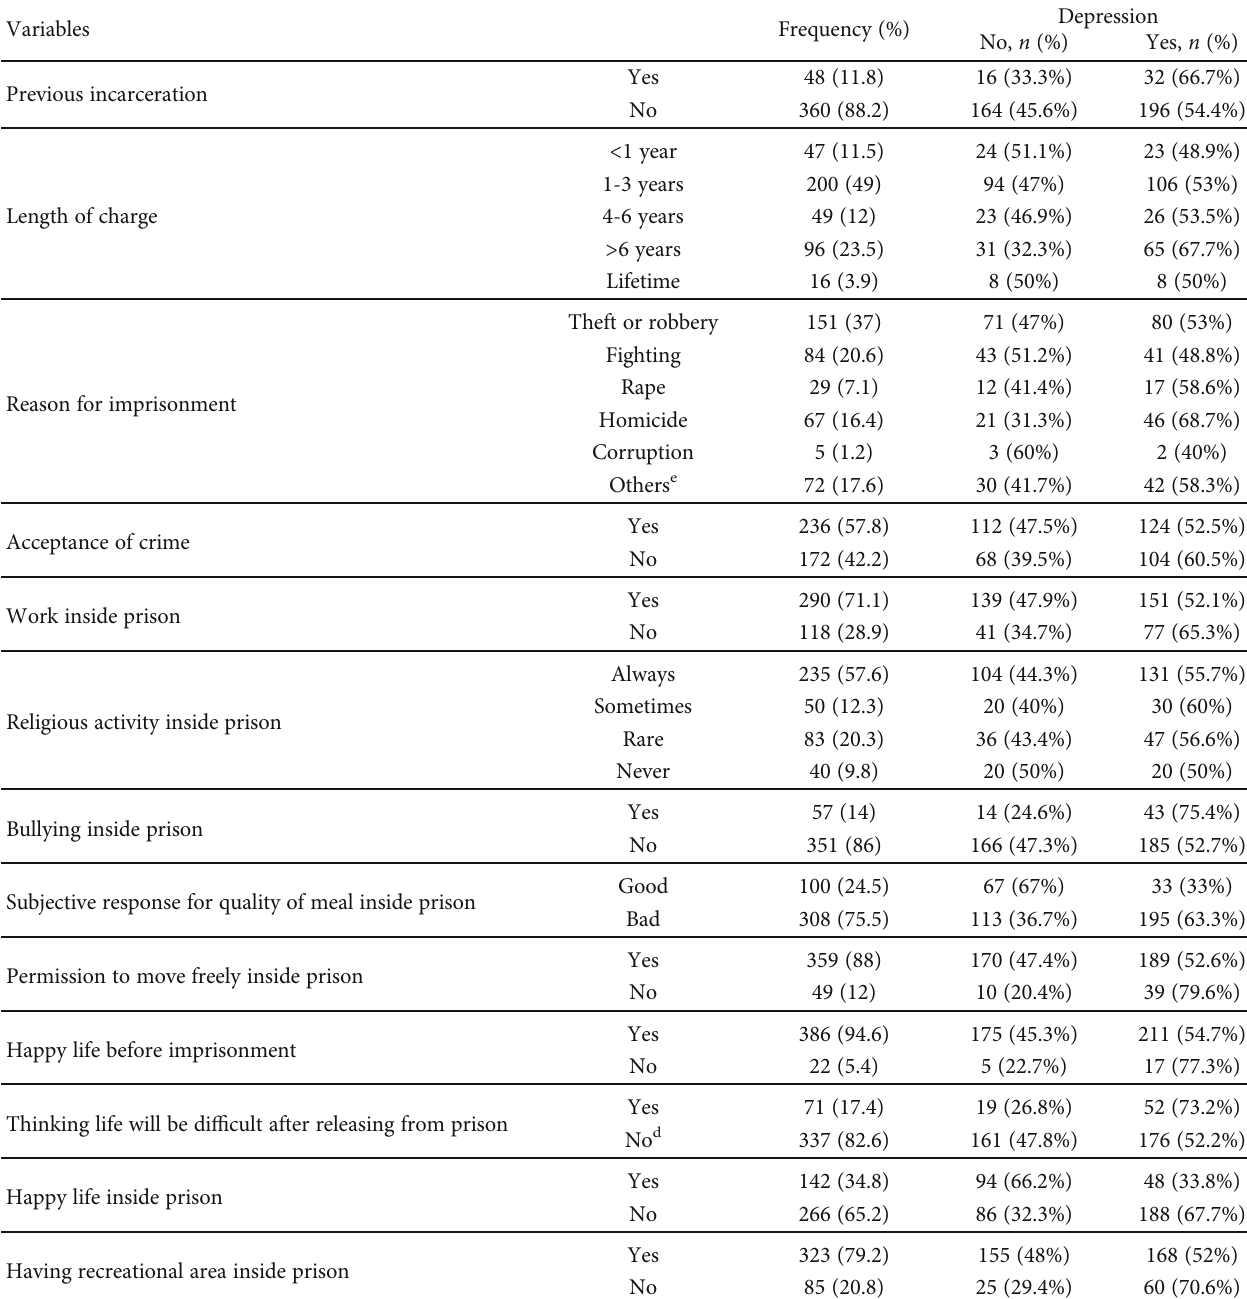
Table 3: Prison-related characteristics of prisoners in Mekelle General Prison Center, Tigray, Ethiopia, 2019 ( n = 408 ).